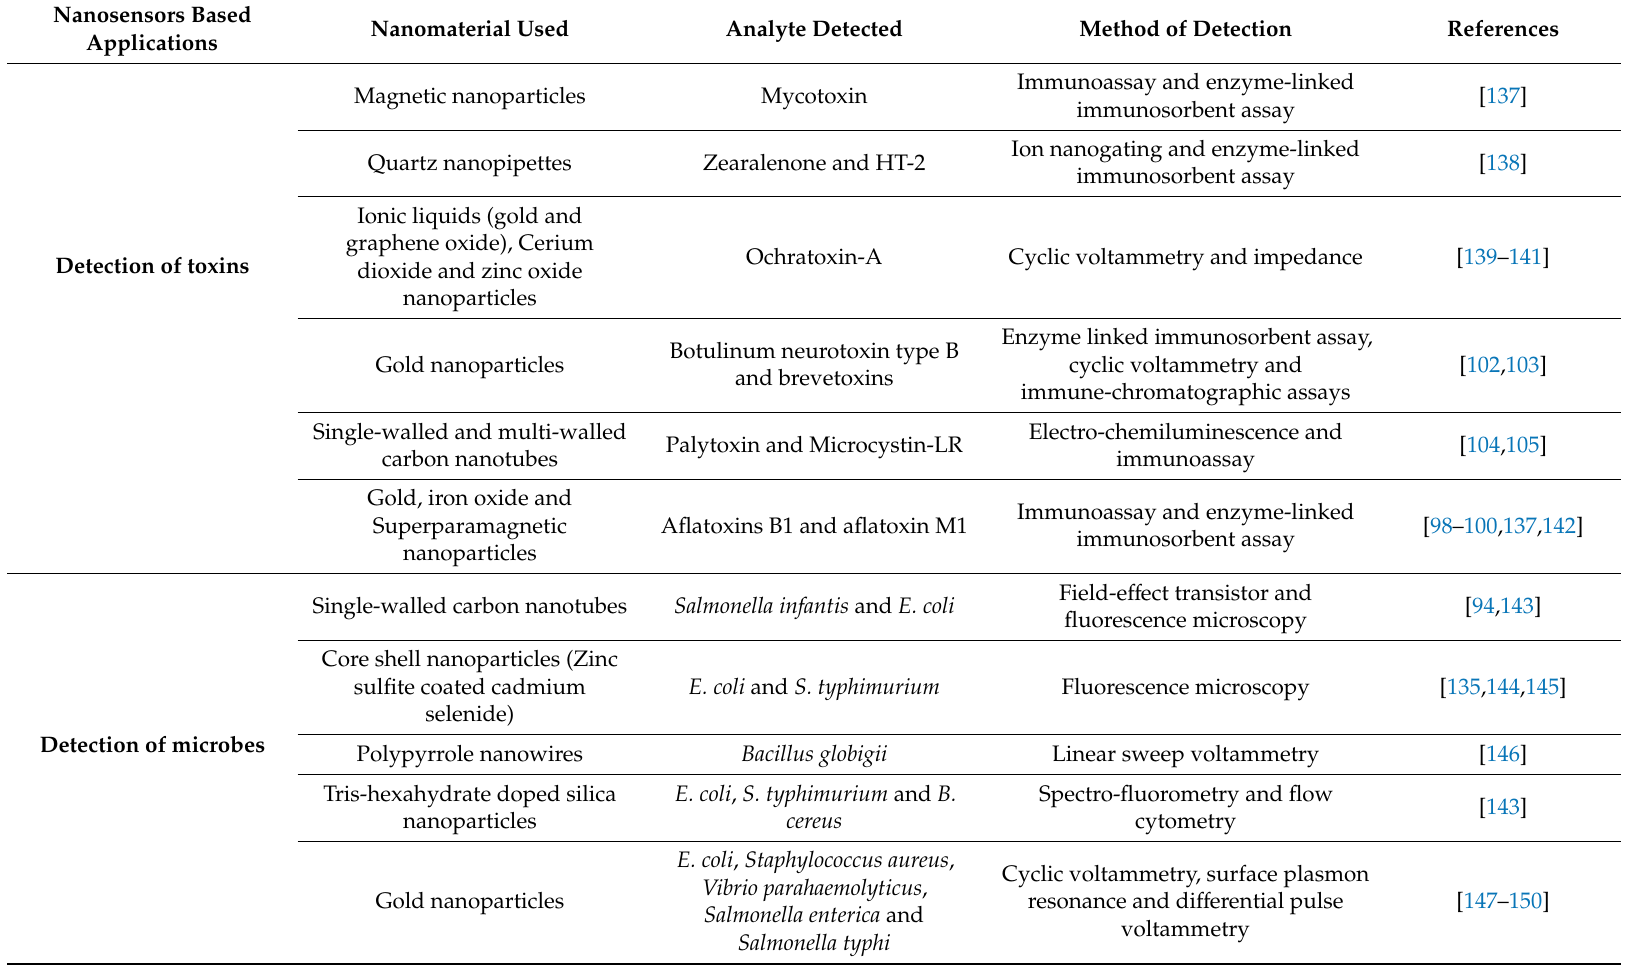
Table 2. Summary of various applications of nanosensors in ensuring food quality and